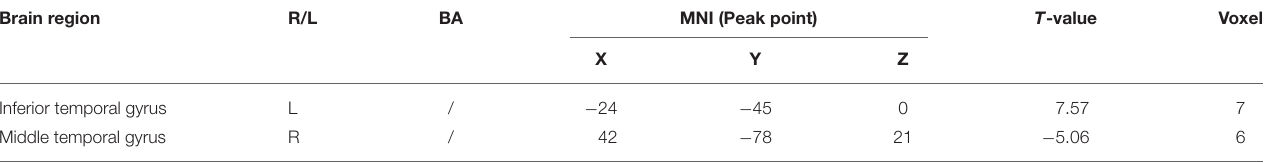
TABLE 5 | Regions showing significant correlation in the change in fALFF in the treatment group to the change in ADAS–cog. Brain region R/L BA MNI (Peak point) T -value